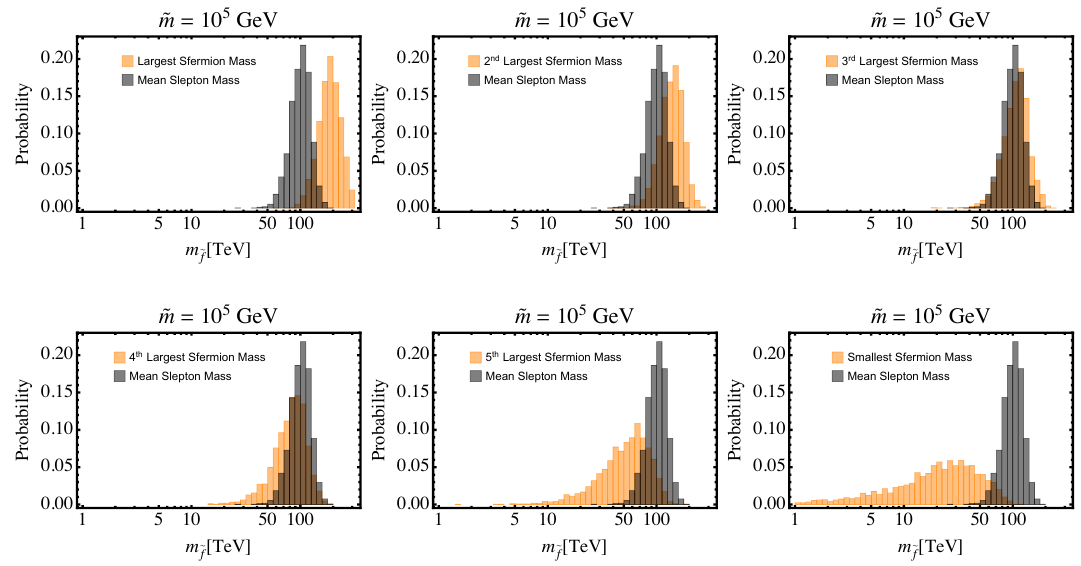
Figure 9 . The distribution of different slepton masses across different good trials for the charge assignment in the first row of table 2 with ˜ m = 100 TeV. The orange histograms show the distribu- tion of different mass eigenvalues, while the black histogram denotes the average slepton mass in different trials. Note that the average masses are sharply concentrated around ˜ m . While the heav- iest eigenvalues are within an O (1) factor of ˜ m , the lightest eigenvalue for this charge assignment can be, in rare occasions, more than an order of magnitude smaller than the average slepton